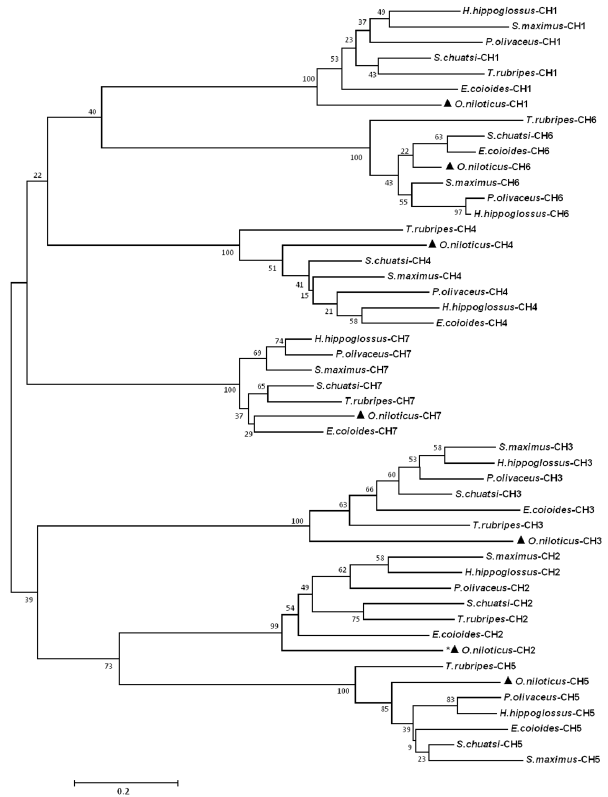
Figure 4. Phylogenetic analysis of IgD CH domains in teleost by using the Neighbor-Joining method. Bootstrap values are indicated at nodes. The IgD CH domains of Nile tilapia are indicated with black triangles. The CH2 domain of Nile tilapia is clustered closely with CH5 indicated with asterisks (*). GenBank accession numbers are as follows: O. niloticus KF530821; S. chuatsi ACO88906.1; E. coioides AFI33218.1; P. olivaceus BAB41204.1; H. hippoglossus AAL79933.1; S. maximus AFQ38975.1; T. rubripes BAD34541.1.